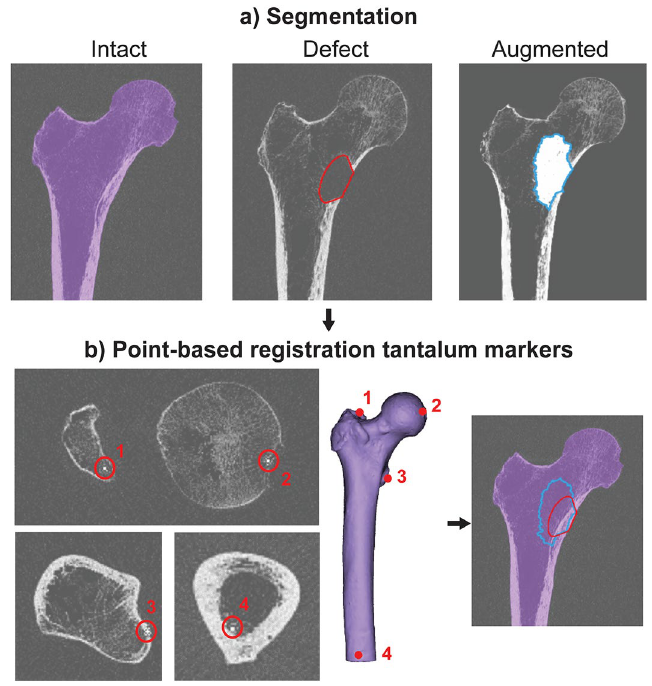
Figure 2. Segmentation and registration. ( a ) The femur, lesion and cement contour were segmented from the intact, defect and augmented CT scan respectively. ( b ) The lesion and cement contour were superimposed on the intact CT scan after a point-based registration of the four tantalum markers in each femur [at the top of the greater trochanter (1), the fovea of the femoral head (2), the lesser trochanter (3) and the posterior endosteal surface at the distal end of the femoral shaft